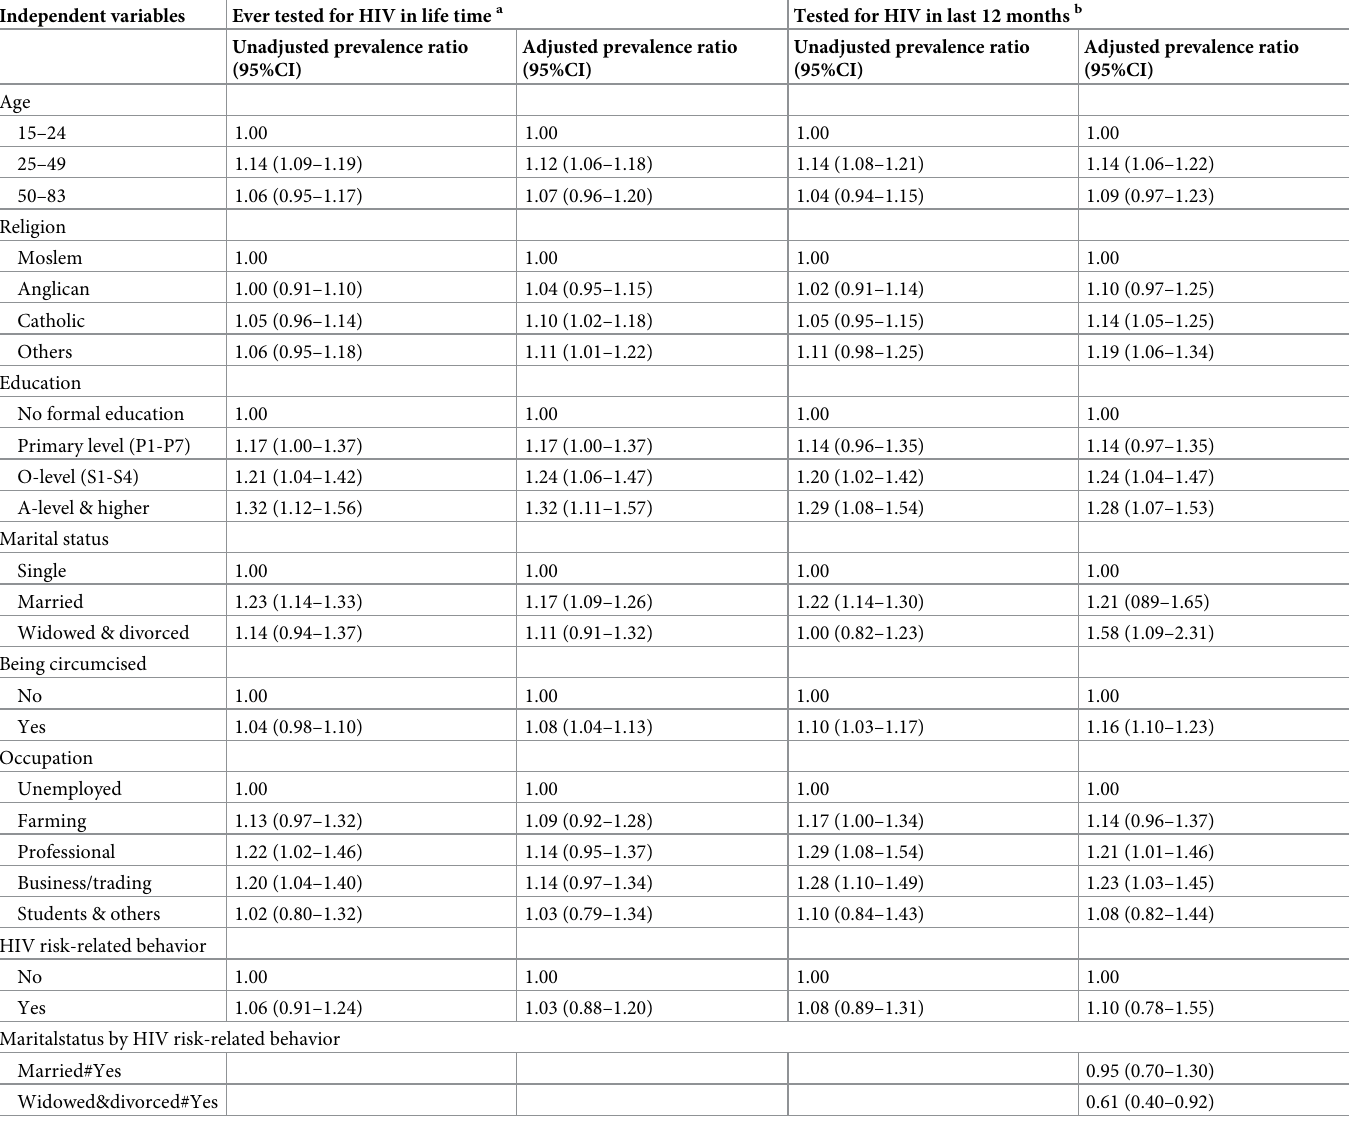
Table 3. Socio-demographic and behavioral characteristics associated with HIV testing among male survey participants from selected villages in Mpigi district, August to September 2018. Independent